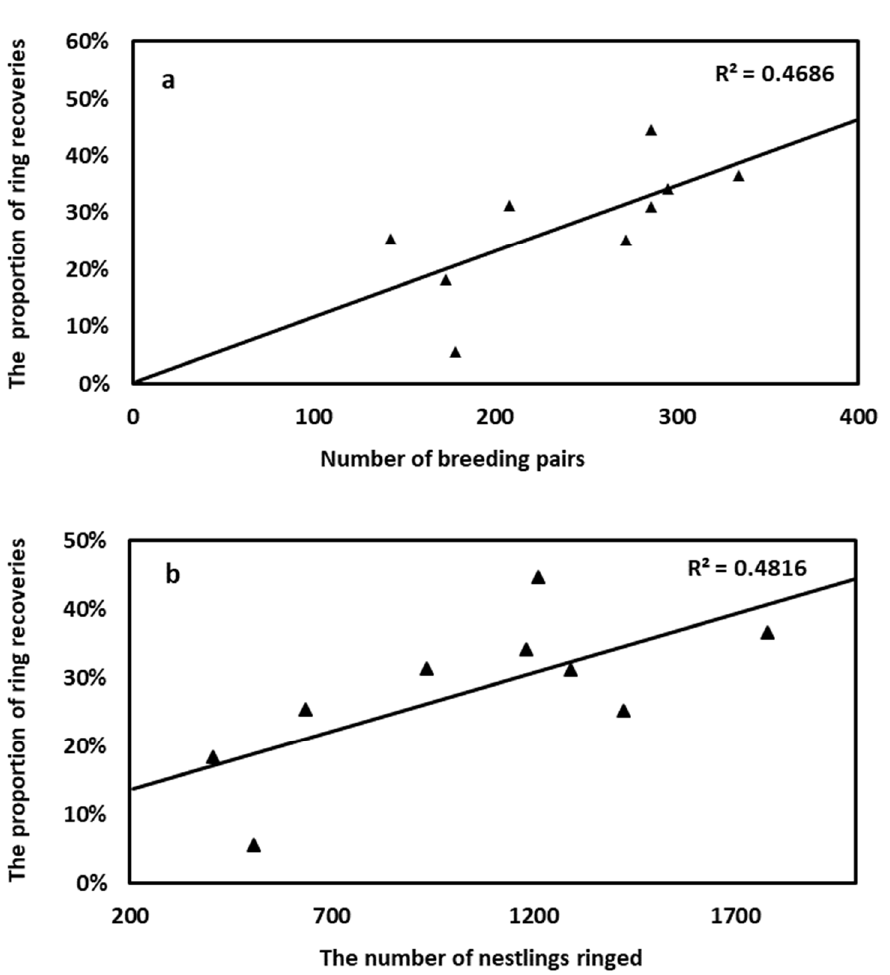
Figure 5. ( a , b ) The proportion of barn owl roadkills from 2009 to 2017 that were ring recoveries was positively related to the number of breeding pairs ( a ) and the number of nestlings ringed ( b ).